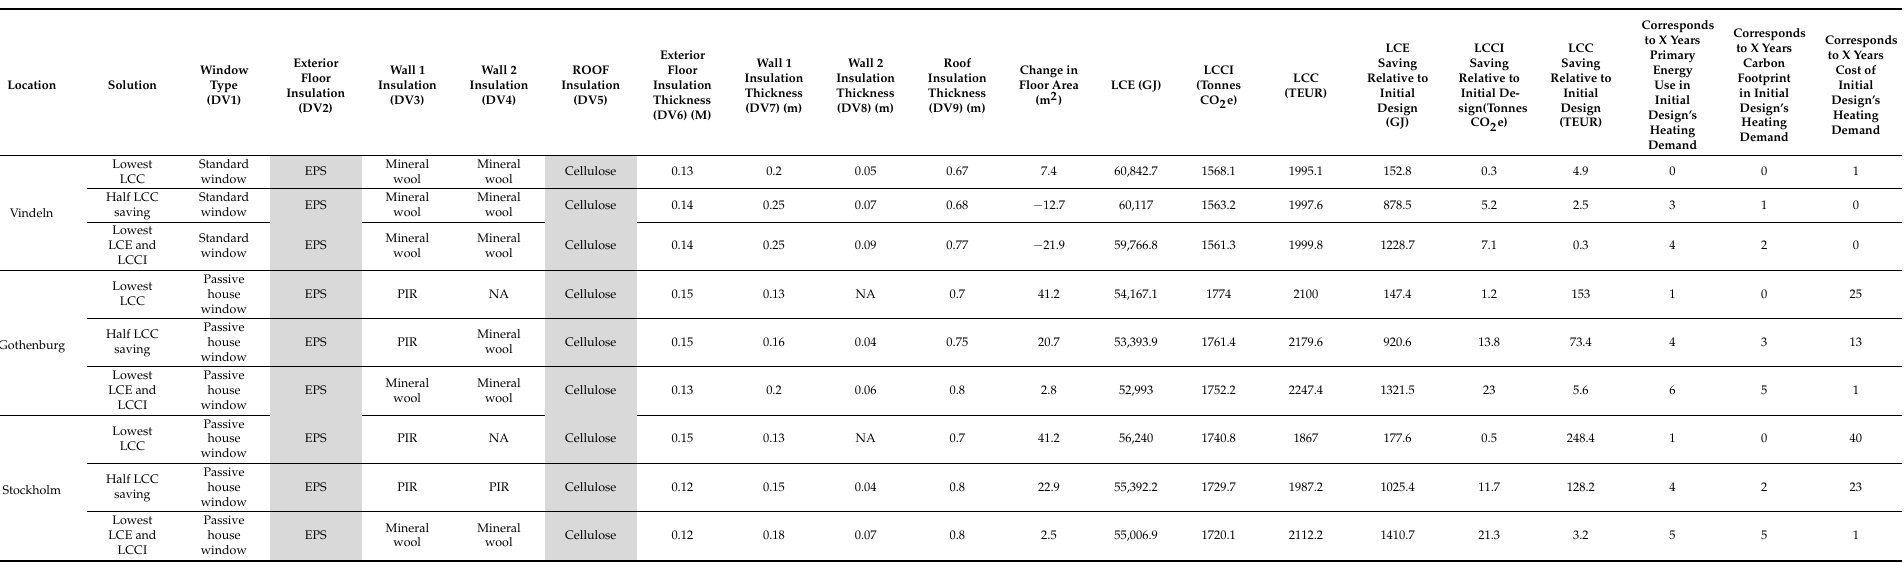
Table 7. List of three desirable Pareto solutions and their design variables for different locations. These solutions are (1) the desirable Pareto solution with lowest LCC, (2) the desirable Pareto solution with the lowest environmental impact (i.e., LCCI and LCC), and (3) the desirable Pareto solution with half LCC saving relative to the solution providing lowest LCC. Minus signs in this table indicate a reduction in floor area relative to the initial design’s total floor